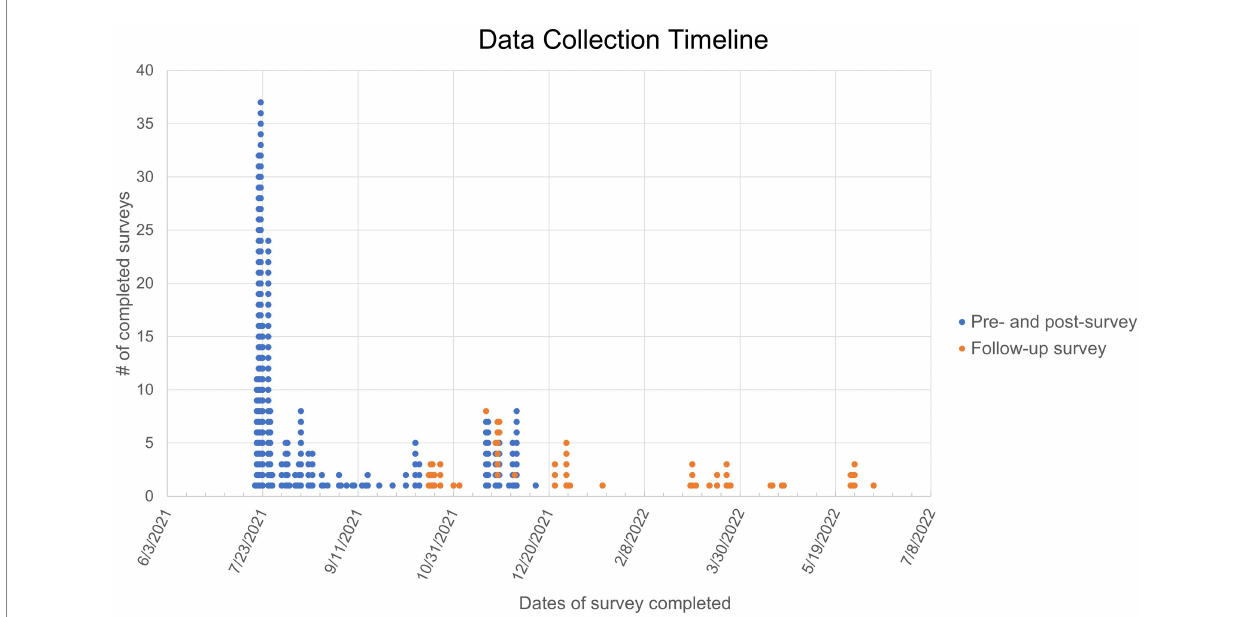
FIGURE 1 Dot plot representing survey completion dates. Each dot represents one participant. The pre- and post-survey completion dates are indicated in blue. The follow-up survey completion dates are indicated in orange.